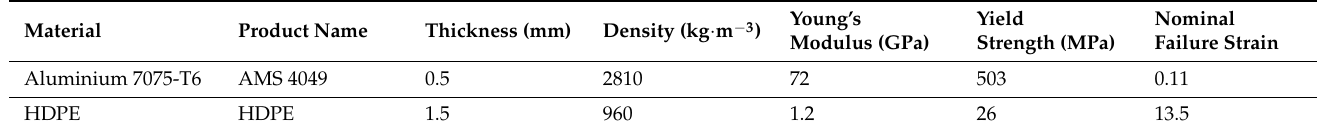
Table 1. Key specifications of the materials used in this